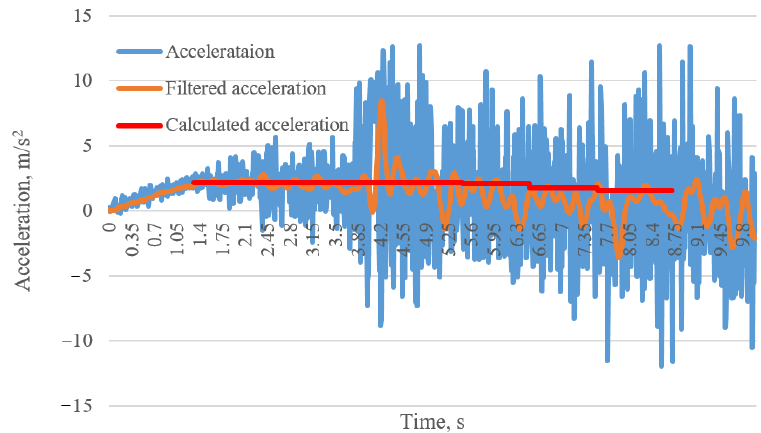
Figure 7. First test’s acceleration results compared with calculated results.